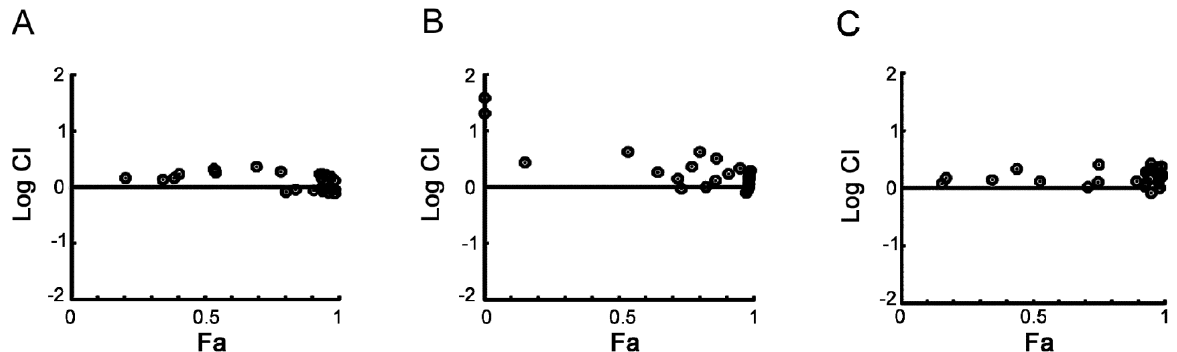
Figure S1. Sequential combination analysis of PHA-767491 with drugs constituting standard of care. MM1S cells were treated with PHA-767491 for 3 h followed by treatment with Melphalan (Range 2 to 32 µM, A ) Doxorubicin (Range 31 to 500 nM, B ) Bortezomib (Range 1.3 to 20 nM, C ) in a non-constant ratio. Cell viability was examined by CellTiter Glo 48 h after drug treatment. Combination indices (CI) were calculated and the Log CI (circles) plotted in relation to the fraction of cells affected (Fa) at any given experimental point.